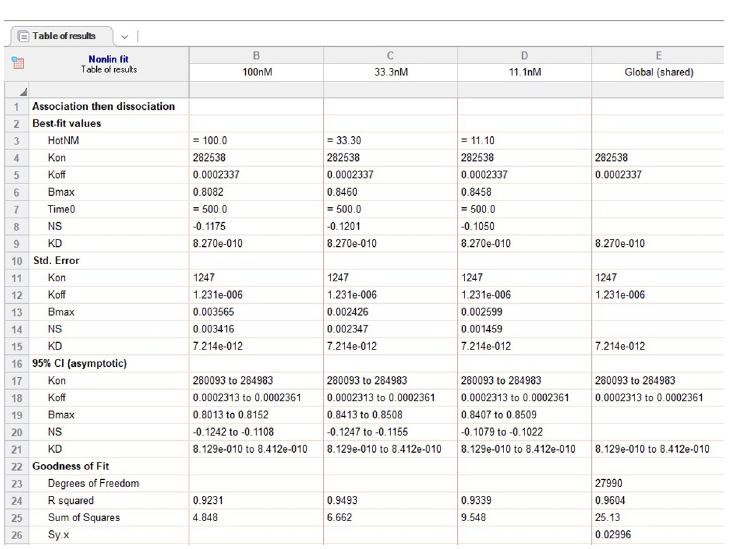
Fig 2. GraphPad Prism data output. A screenshot of results from the GraphPad Prism “Association then Dissociation” model for SbtR binding to its consensus sequence is presented.